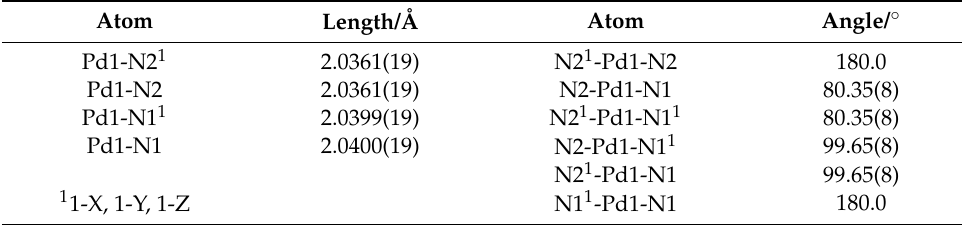
Figure 1. The ORTEP diagram of C1 with the thermal ellipsoids drawn at the 50% probability level. Table 1. Selected geometrical parameters for C1 .